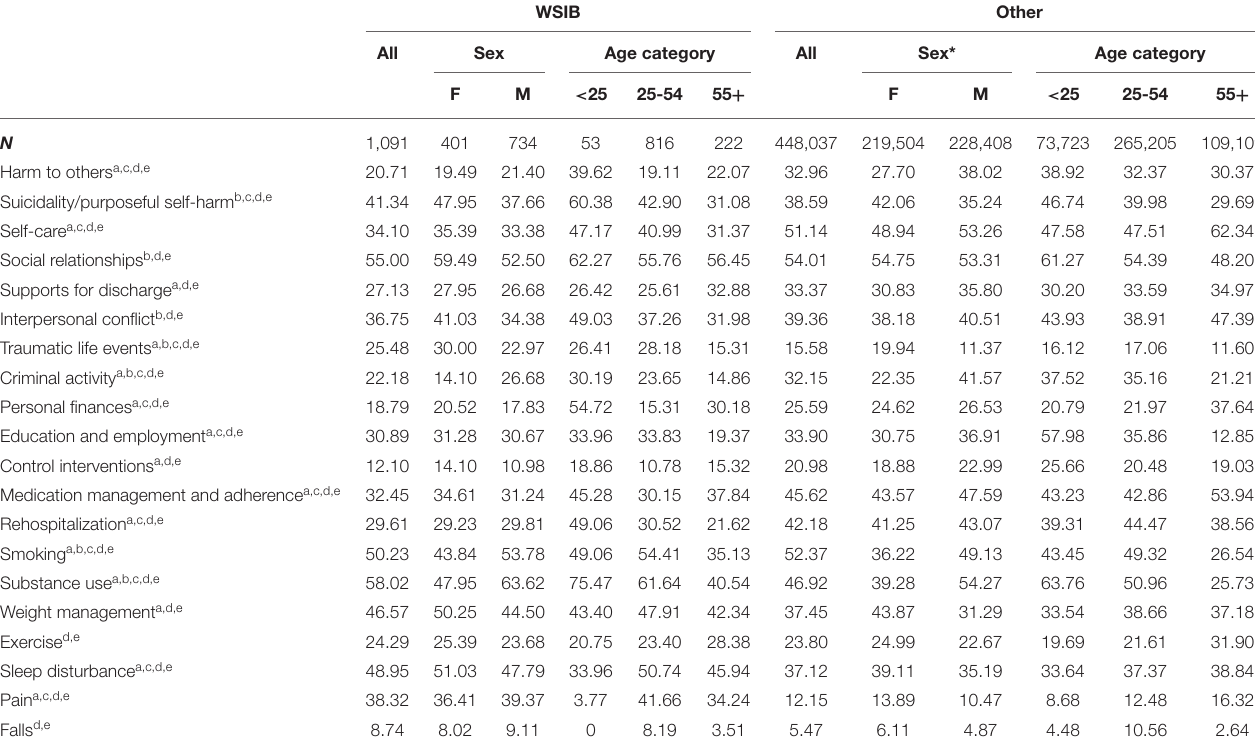
TABLE 4 | Univariate distribution (%) for areas of need overall, and by WSIB status, sex, and age. WSIB Other All Sex Age category All Sex* Age category